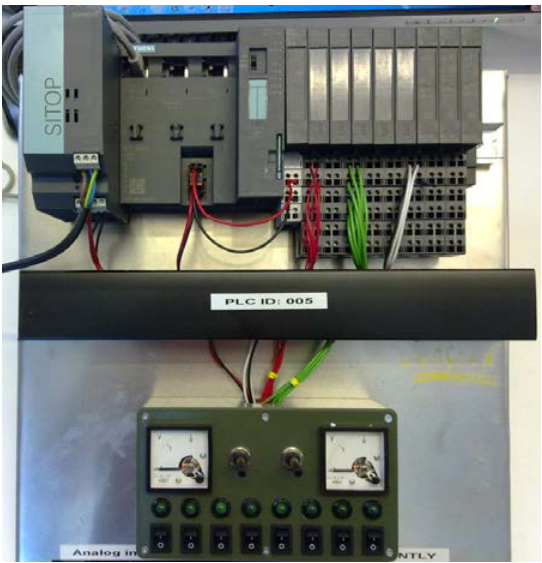
Figure 3. The hardware setup showing the used SIEMENS ET 200S and peripheral